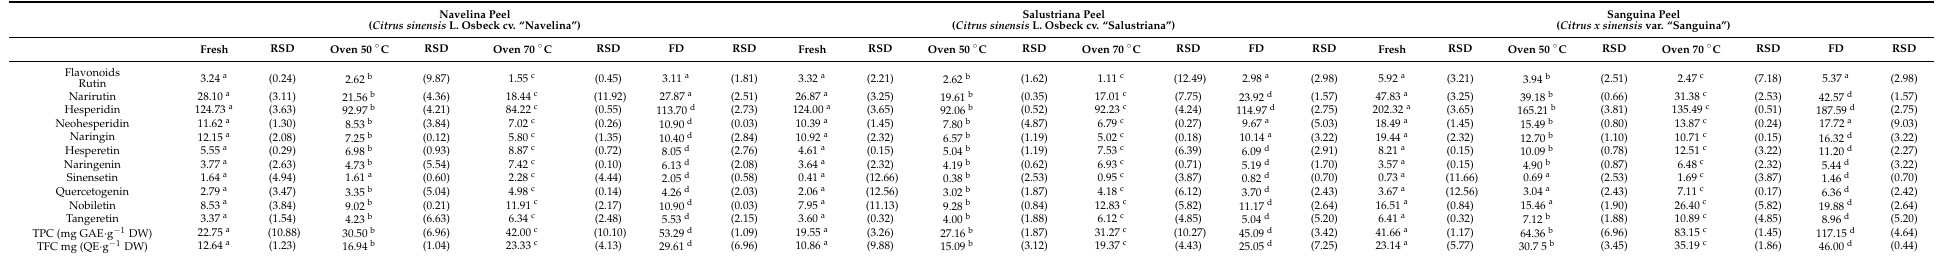
Table 4. Mean concentration of flavonoids (mg. g − 1 DW) in Navelina, Salustriana, and Sanguina peels, both fresh and after drying treatment: oven-dried (50 ◦ C), oven-dried (70 ◦ C), and freeze-dried